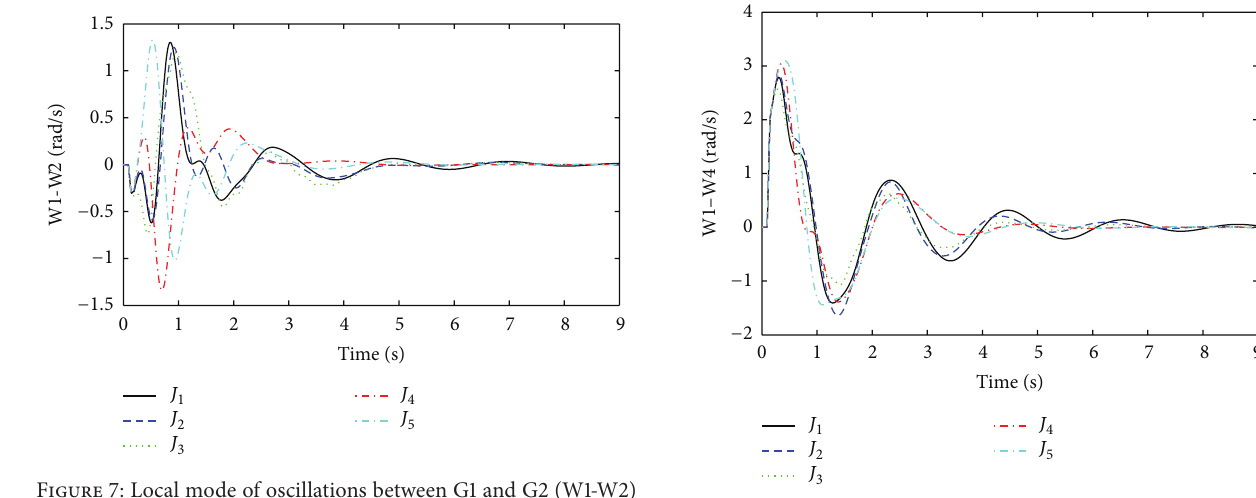
Figure 9: Interarea mode of oscillations between G1 and G4 (W1– W4) for three-phase fault at bus 13.